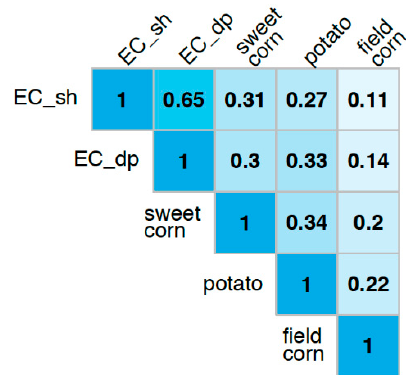
Figure 10. Kendall’s tau correlation coe ffi cient matrices for all six fields (H, G, P, L, E, and W) together. Correlations are for the following parameters: shallow and deep apparent electrical conductivity (EC_sh and EC_dp, respectively) and relative evapotranspiration for each crop rotation (‘sweet corn’, ‘potato’, and ‘field corn’). Correlations are all statistically significant at an alpha level of 0.001. Table 4. Recommended precision irrigation actions based on intrafield relative ET and EC a.